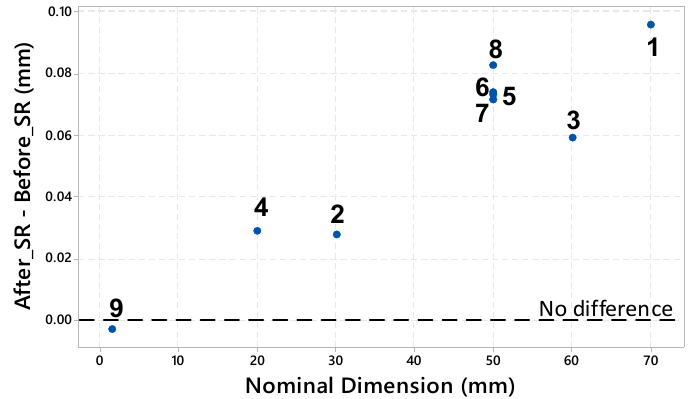
Figure 5. Stress relief effect depending on the feature’s nominal size .